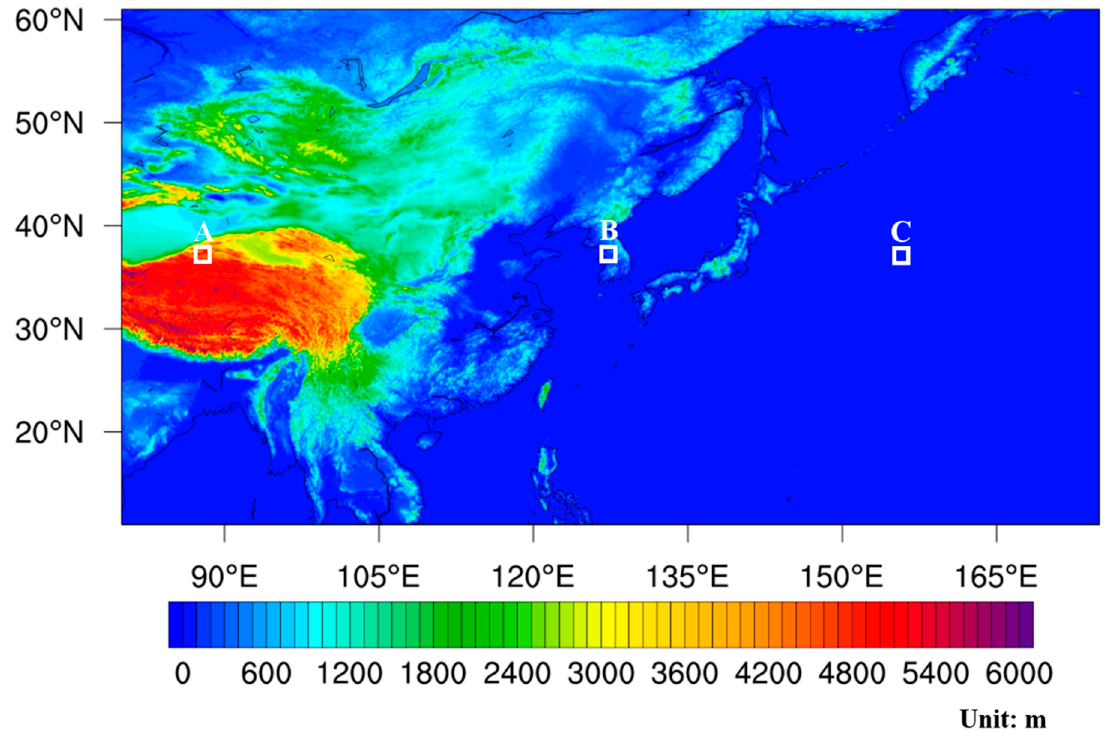
Figure 6. Three regions of East Asia for comparison of energy budget components. A, B, and C represent mountain, plain, and ocean, respectively.